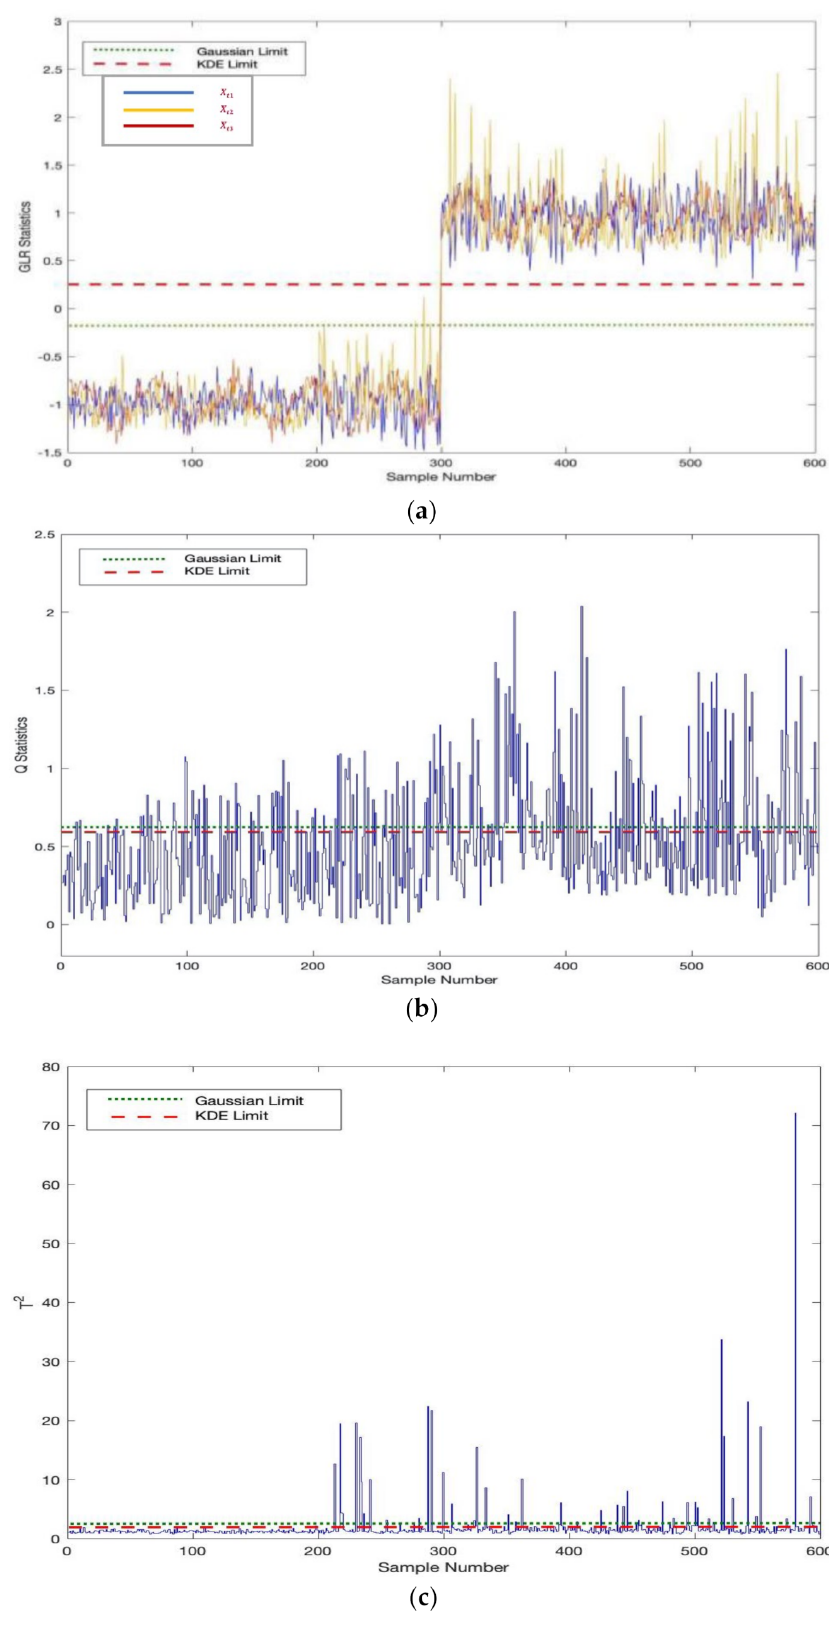
Figure 6. ( a ) KPCA-KDE-based SSGLR charts; ( b ) monitoring fault using KPCA-KDE-based Q chart; ( c ) monitoring fault using KPCA-KDE-based T 2